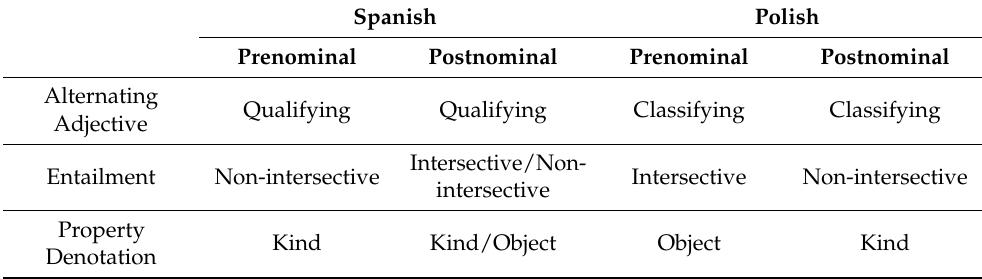
Table 1. Semantic differences between Spanish and Polish